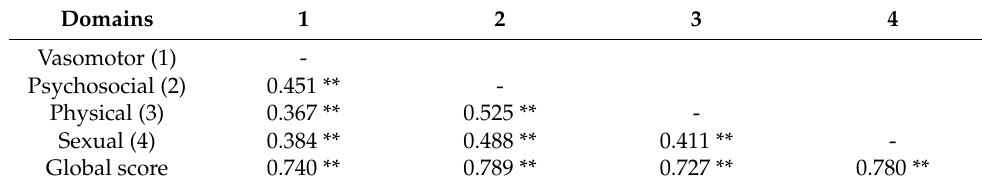
Table 5. Correlations between the MENQOL domains of menopausal women.